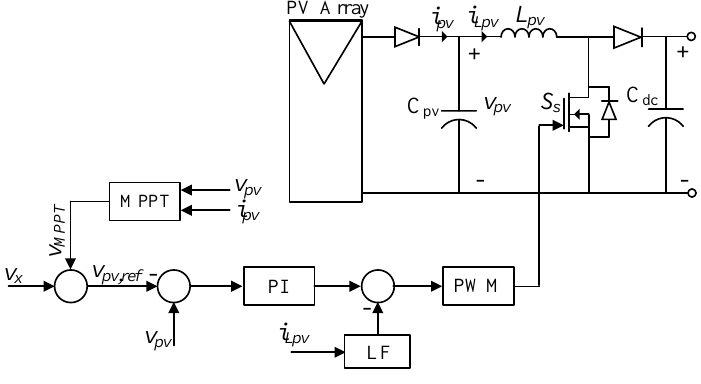
Figure 8. Control of the DC/DC boost